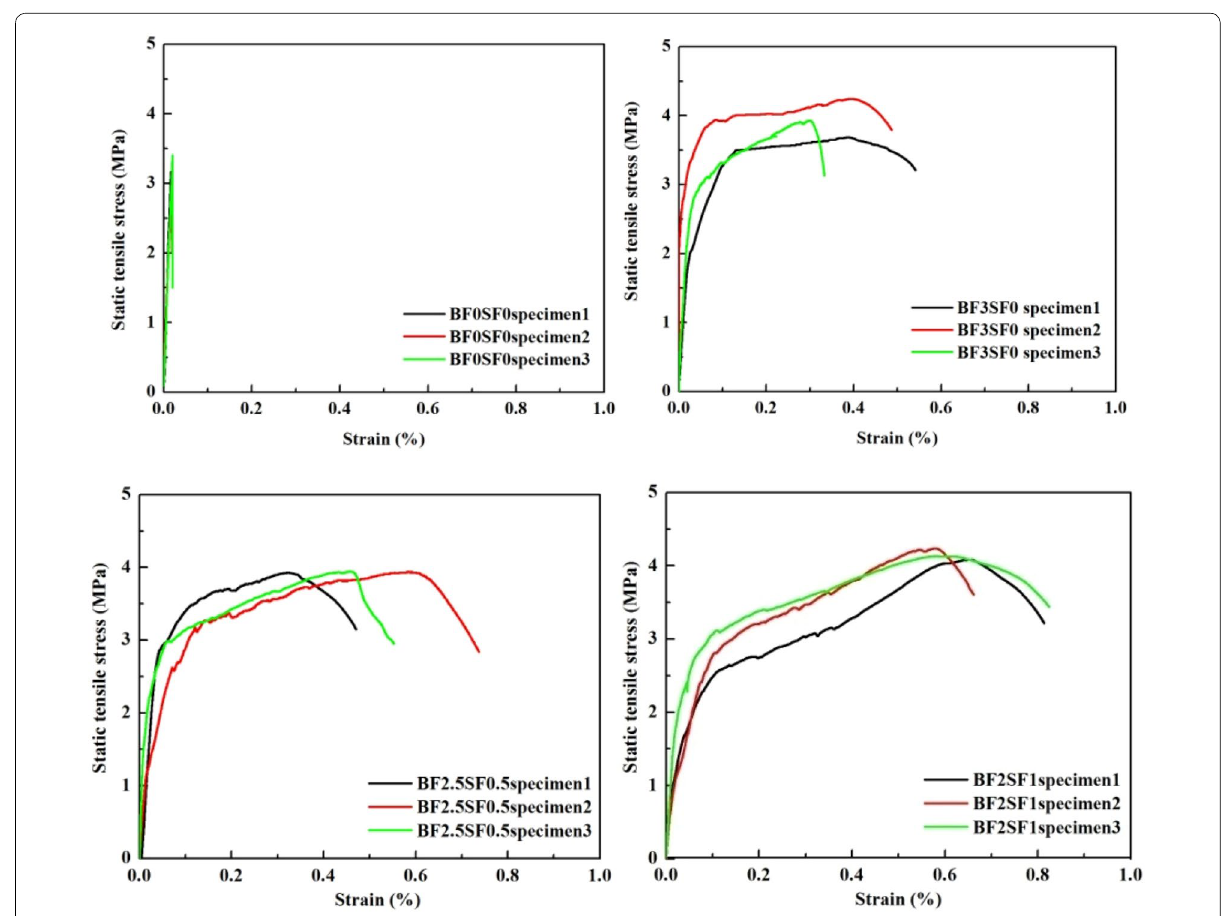
Fig. 4 Static tensile stress–strain curves of various